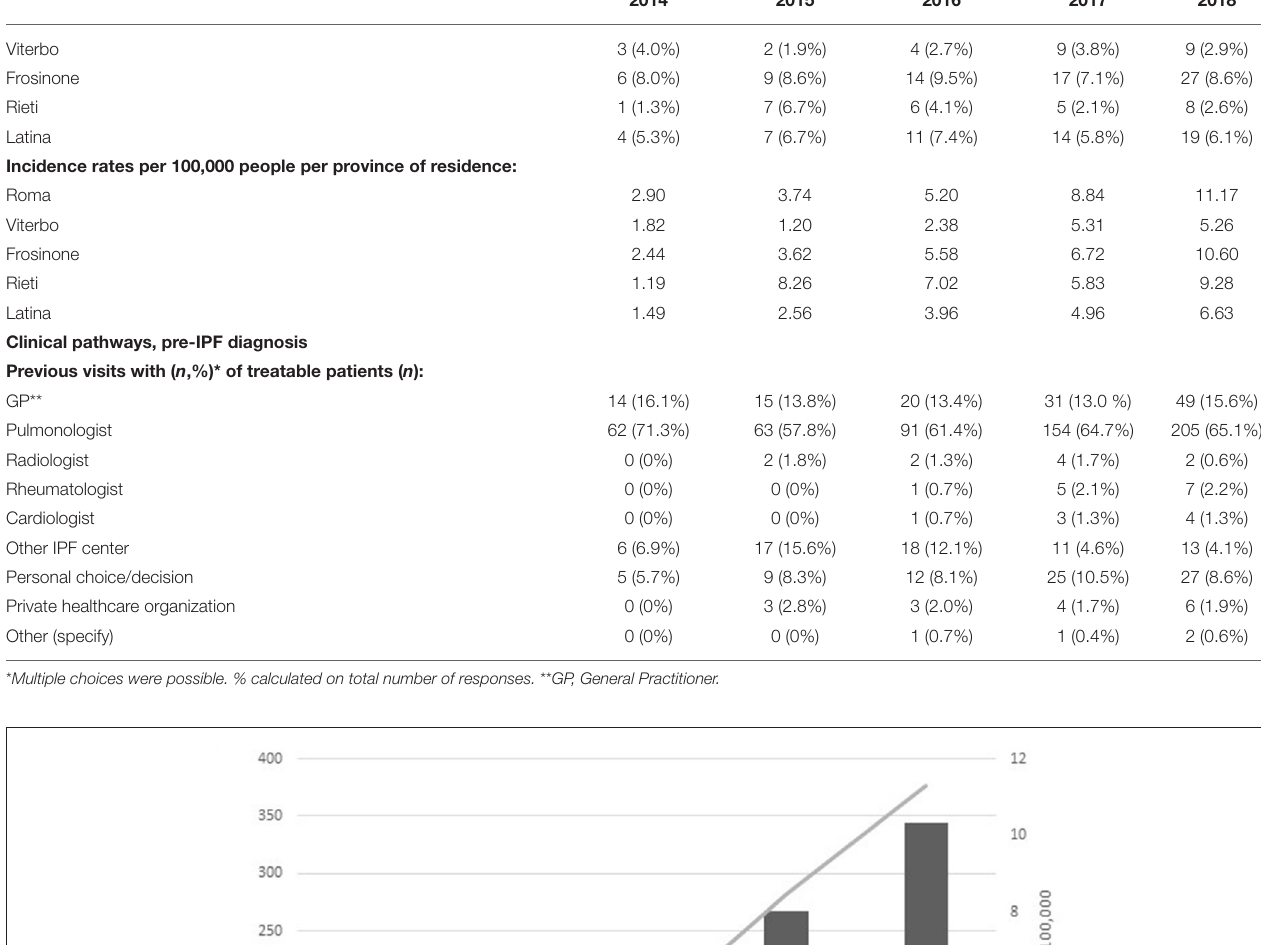
define a case of IPF, but mainly to the evolution of the age structure of the population. The findings are in line with previous reports (13, 14), where a rising incidence of the disease over